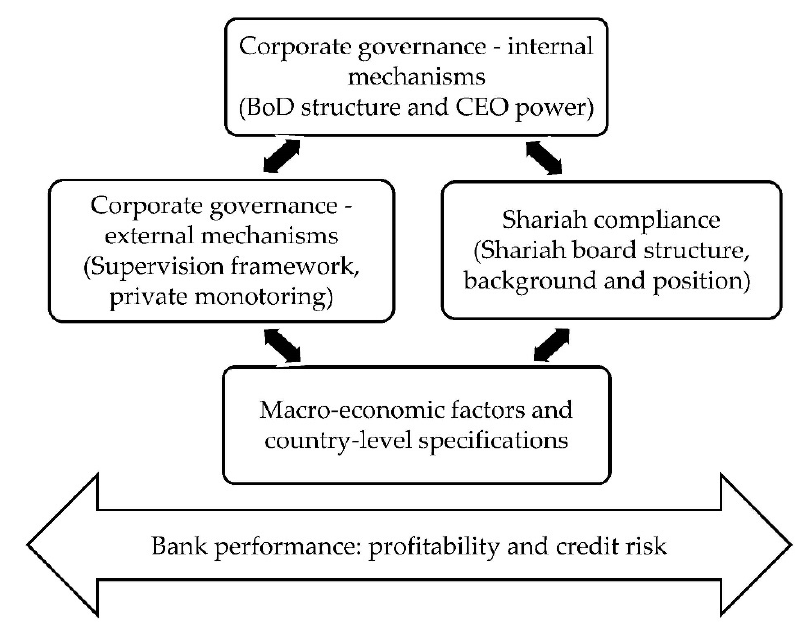
Figure 1. Bank multi-layer corporate governance framework (proposed by authors).